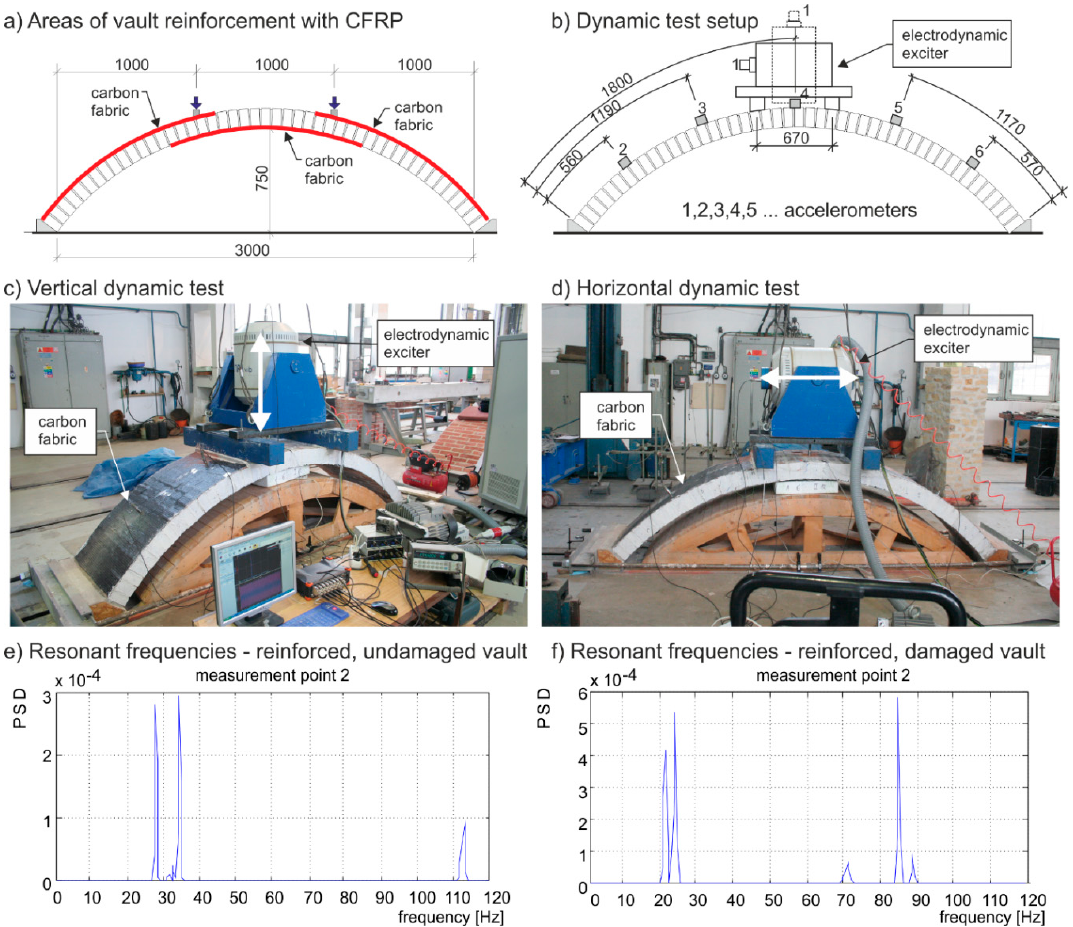
Figure 12. ( a ) Schematic of masonry barrel vault’s reinforcement with carbon fabrics; ( b ) schematic of mounting the electro-dynamic exciter and arrangement of accelerometers on the masonry vault; ( c ) electro-dynamic exciter for vertical oscillations; ( d ) electro-dynamic exciter for horizontal oscillations; ( e ) identified resonant frequencies before the reinforced vault’s failure; and ( f ) vault response spectra and identification of vault’s natural frequencies after the static test.